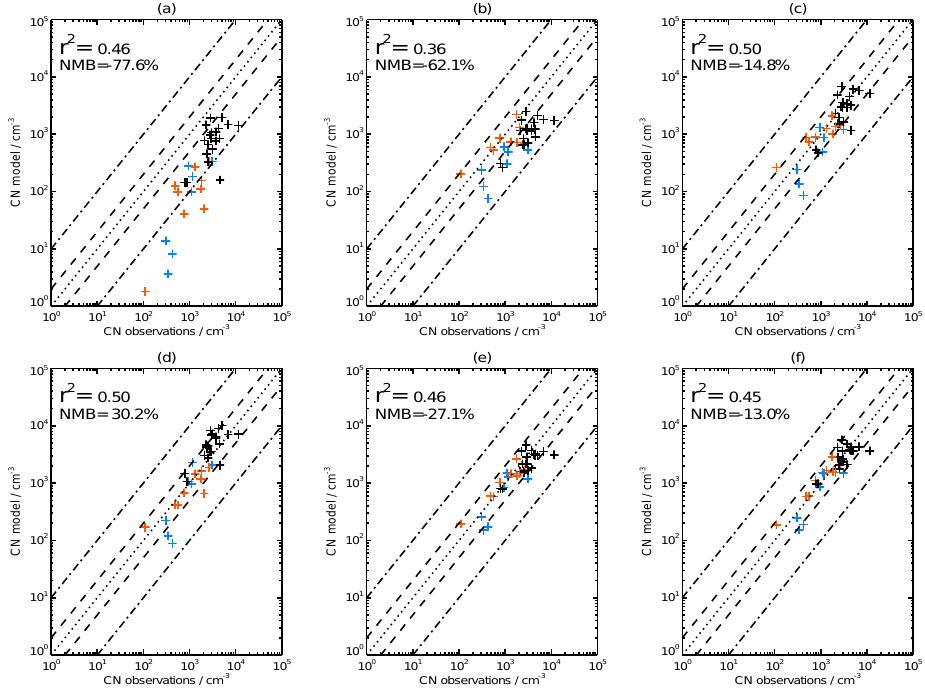
Fig. 3. Scatterplot of simulated (GLOMAP) versus observed annual mean CN concentrations (at ambient temperature and pressure) for the sites shown in Fig. 2. Sites are classified as FT (red), MBL (blue) and continental BL (black) as shown in Table 2. The different model experiments are described in Table 1: (a) Primary emissions only (PRI), (b) Primary emissions and binary homogeneous nucleation (BHN), (c) BHN and increased primary EC/OC (PRICAR), (d) BHN and increased primary sulfate (PRISUL), (e) Primary emissions, BHN and activation particle formation (ACT2), (f) Primary emissions, BHN and kinetic particle formation (KIN2). The Pearson correlation coefficients ( R 2 ) and normalised mean bias (NMB) are shown. The dotted line represents the 1:1 relation and the dashed lines factor of 2 and 10